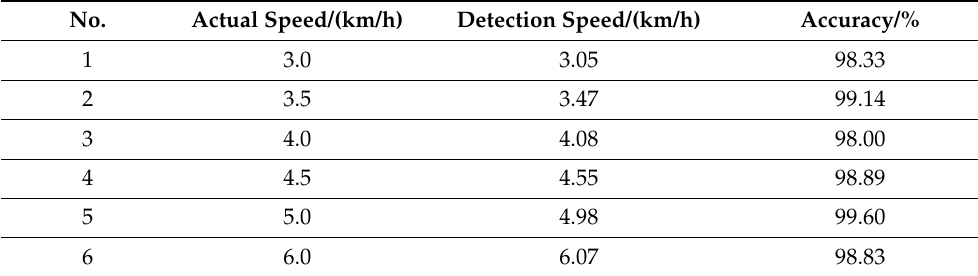
Table 3. Speed sensor calibration test measurement results.